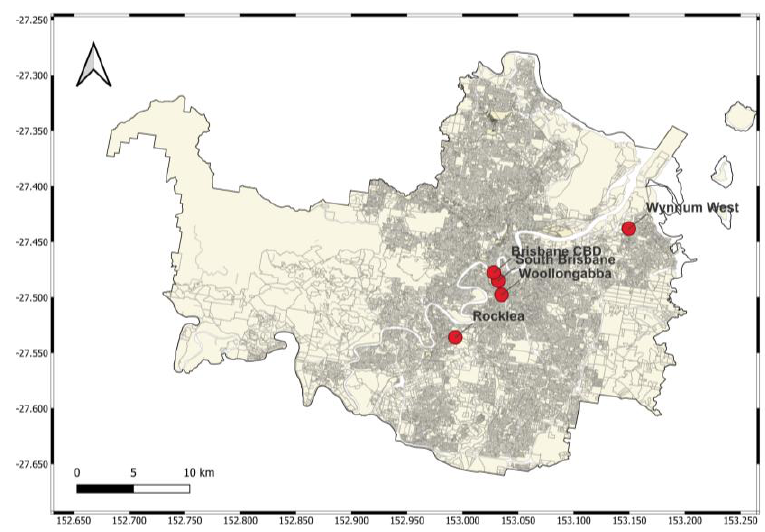
Figure 1. Study area boundary and location of monitoring stations.